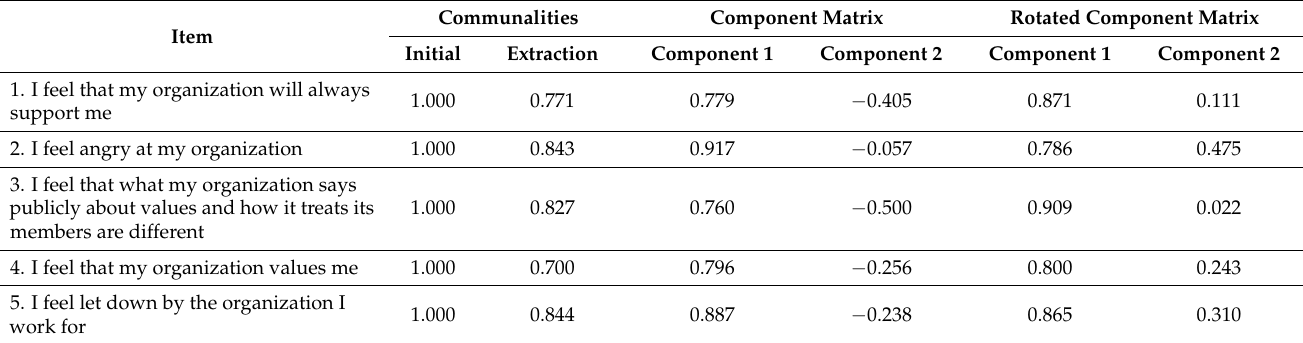
Table 6. WAS item communalities and factor